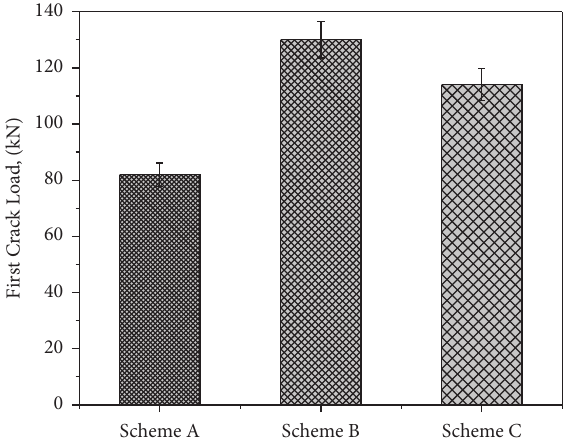
Figure 6: First crack load of beams under three